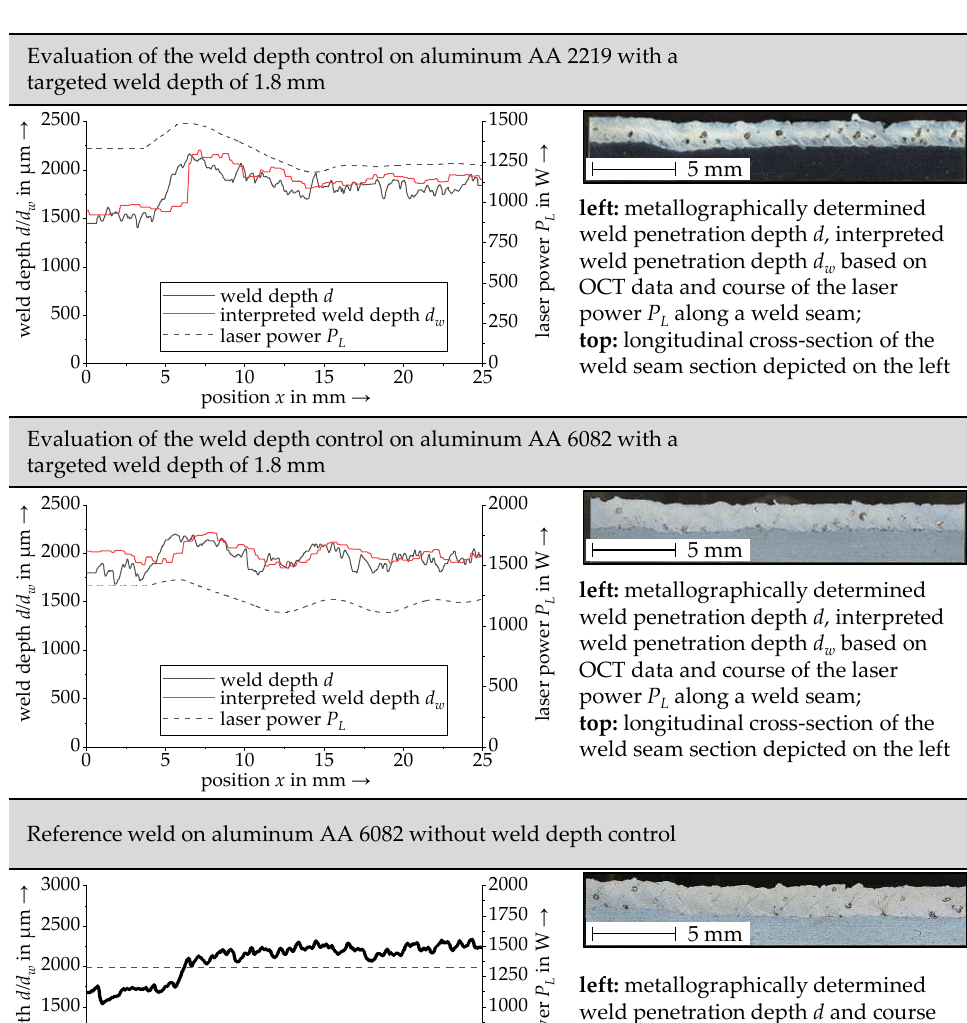
Figure 8. Comparison of the weld depth profiles for a targeted depth of 1.5 mm with a 300 µm deep notch for the aluminum alloy AA2219 with active weld depth control (top), for the aluminum alloy EN AW-6082 with active weld depth control and for the aluminum alloy EN AW-6082 without weld depth control.